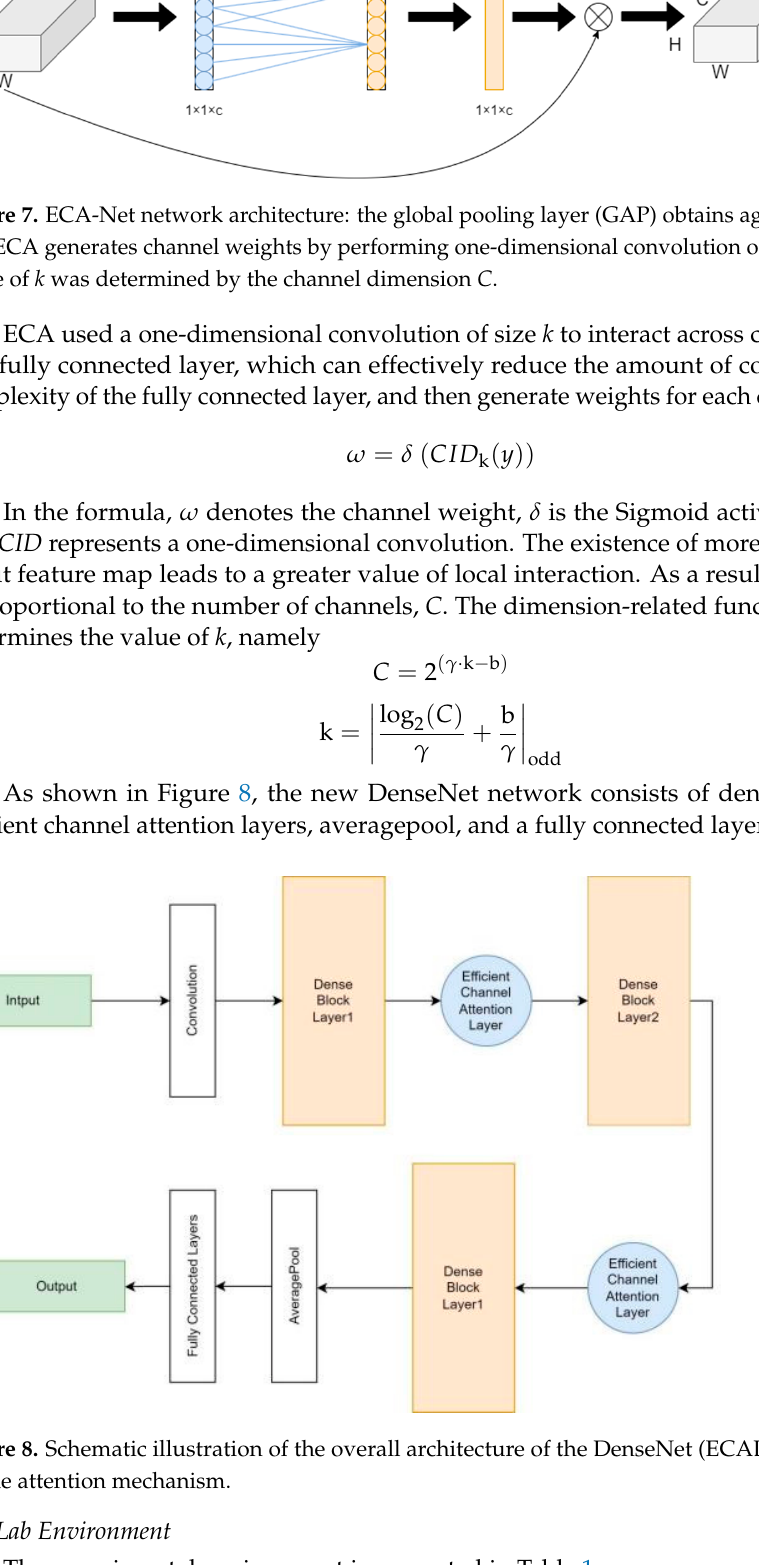
Table 1. Machine configuration information table.